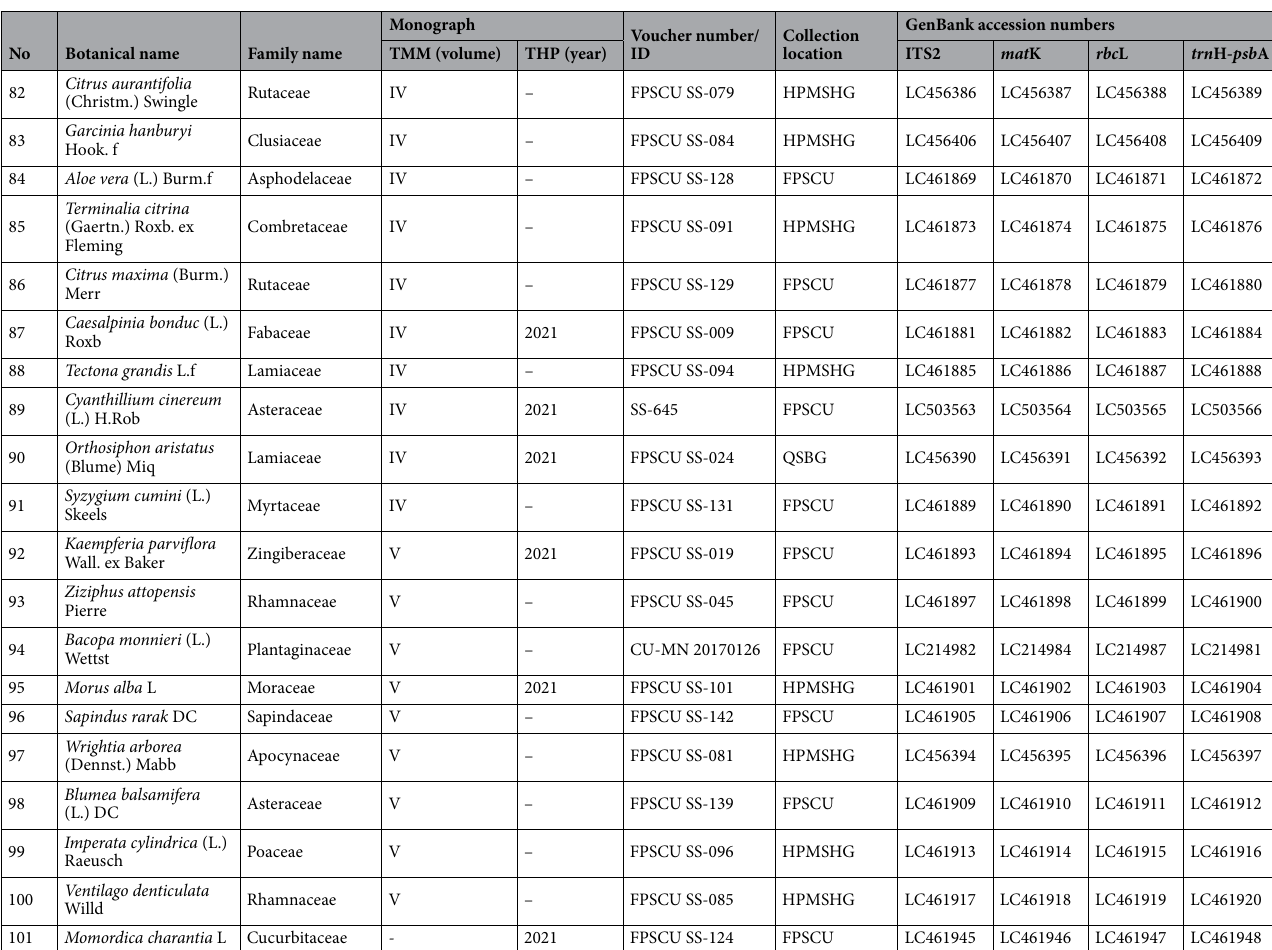
Table 1. List of medicinal plants used in this study and their detailed information. THP Thai Herbal Pharmacopoeia, TMM Thai Materia Medica, FPSCU Faculty of Pharmaceutical Sciences,